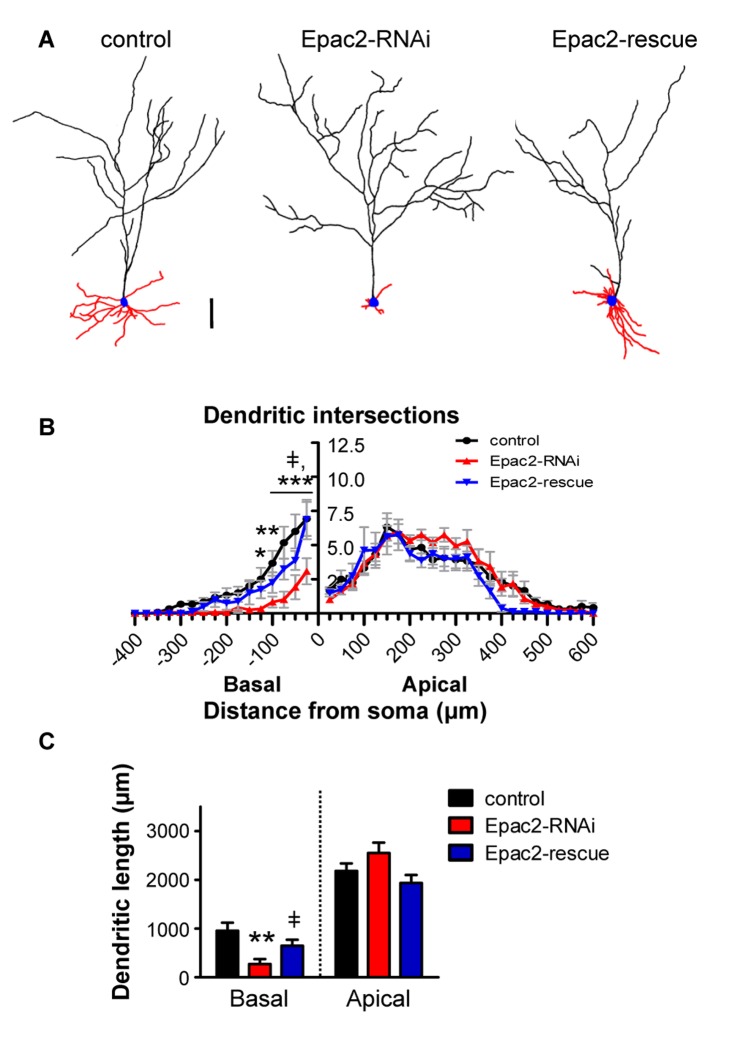
Epac2 is required for selective maintenance of basal dendrite complexity and length.(A) Binary images of cultured cortical neurons (DIV 23–28) expressing GFP, GFP+Epac2-RNAi, or GFP+Epac2-RNAi+Epac2-rescue. (B) Epac2-RNAi selectively reduces complexity of basal arbors. Expression of RNAi-insensitive Epac2-rescue recovers Epac2-RNAi-induced reduction of basal dendrite complexity to control levels. (C) Epac2-RNAi reduces basal dendritic length, while Epac2-rescue prevents this effect. ‡, difference between Epac2-rescue and Epac2-RNAi, p<0.05, *p<0.05, **p<0.01, ***p<0.001; scale bars, 100 µm.